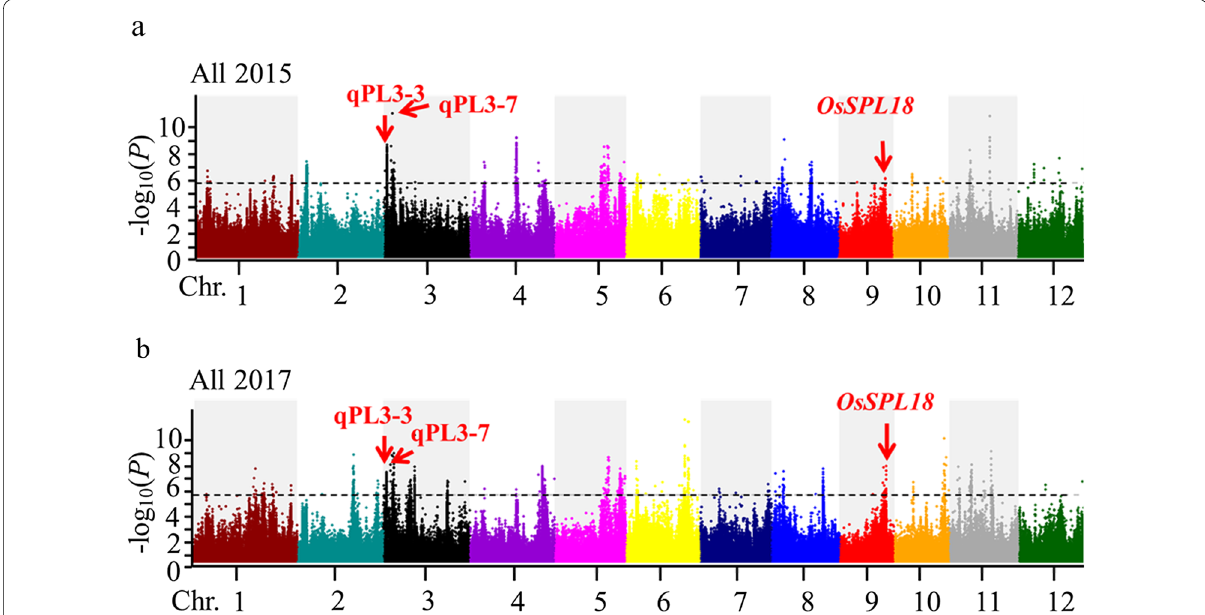
Fig. 2 Manhattan plots of GWAS for panicle length in a 2015 and b 2017 for all accessions. The red arrows represent three significant associations, assigned when the peak SNP correlation exceeds the significance threshold,